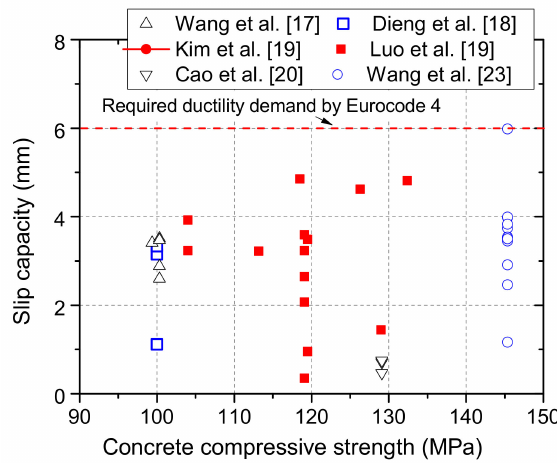
Figure 2. Slip capacities of stud shear connectors in ultra-high performance concrete (UHPC).